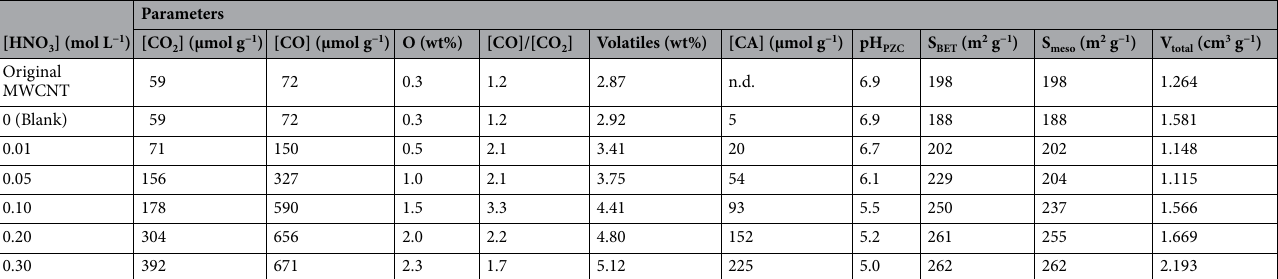
Table 1. Properties of MWCNTs subjected to hydrothermal treatment with different HNO 3 concentrations: amounts of CO 2 and CO released by TPD, [CO/CO 2 ] ratio, percentage of oxygen obtained from the analysis of the TPD spectra (assuming that all the surface oxygen is released as CO and/or CO 2 ), amount of volatiles (determined by TGA), amount of carboxylic acids (CA; corresponding to the sum of SA and LA, as determined by TPD), pH at the point of zero charge (pH PZC ), specific surface area ( S BET ), non-microporous specific surface area ( S meso ) and total pore volume ( V total ). n.d.: Not